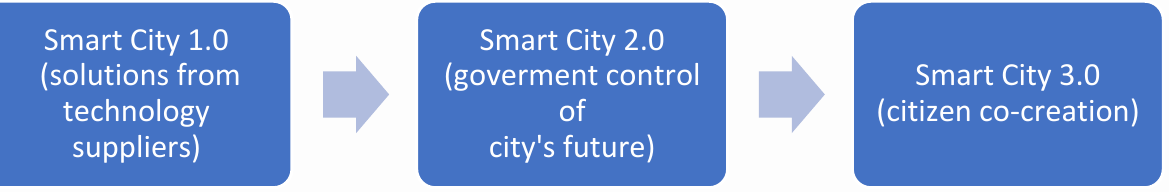
Figure 2. Smart city concepts. Source: adapted from Qonita, M. and Giyarsih, S., 2022 [22].